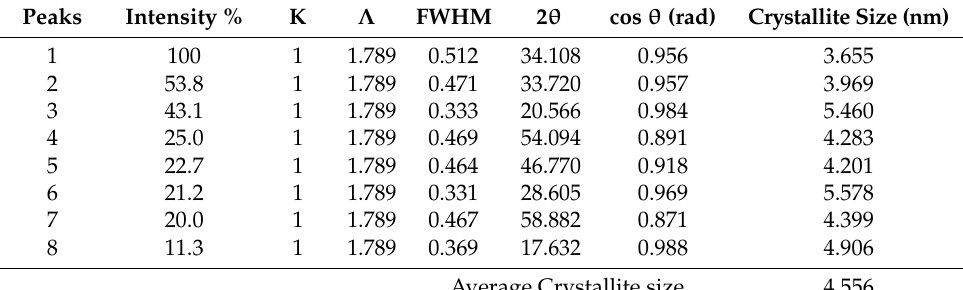
Table 1. Data used for the calculation of average crystallite size of J-K-H synthesized. Peaks Intensity % K Λ FWHM 2 θ cos θ (rad)